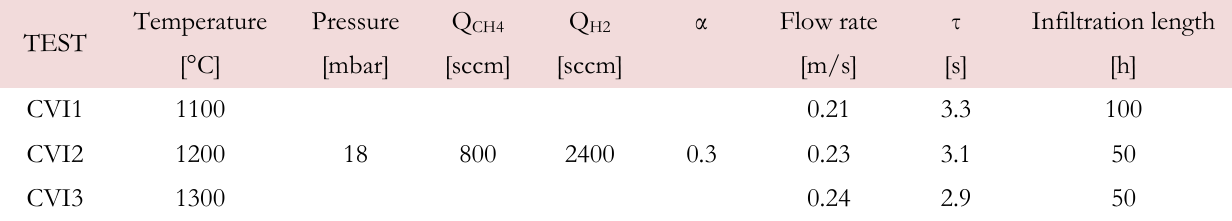
Table 1: Operating condition of the CVI